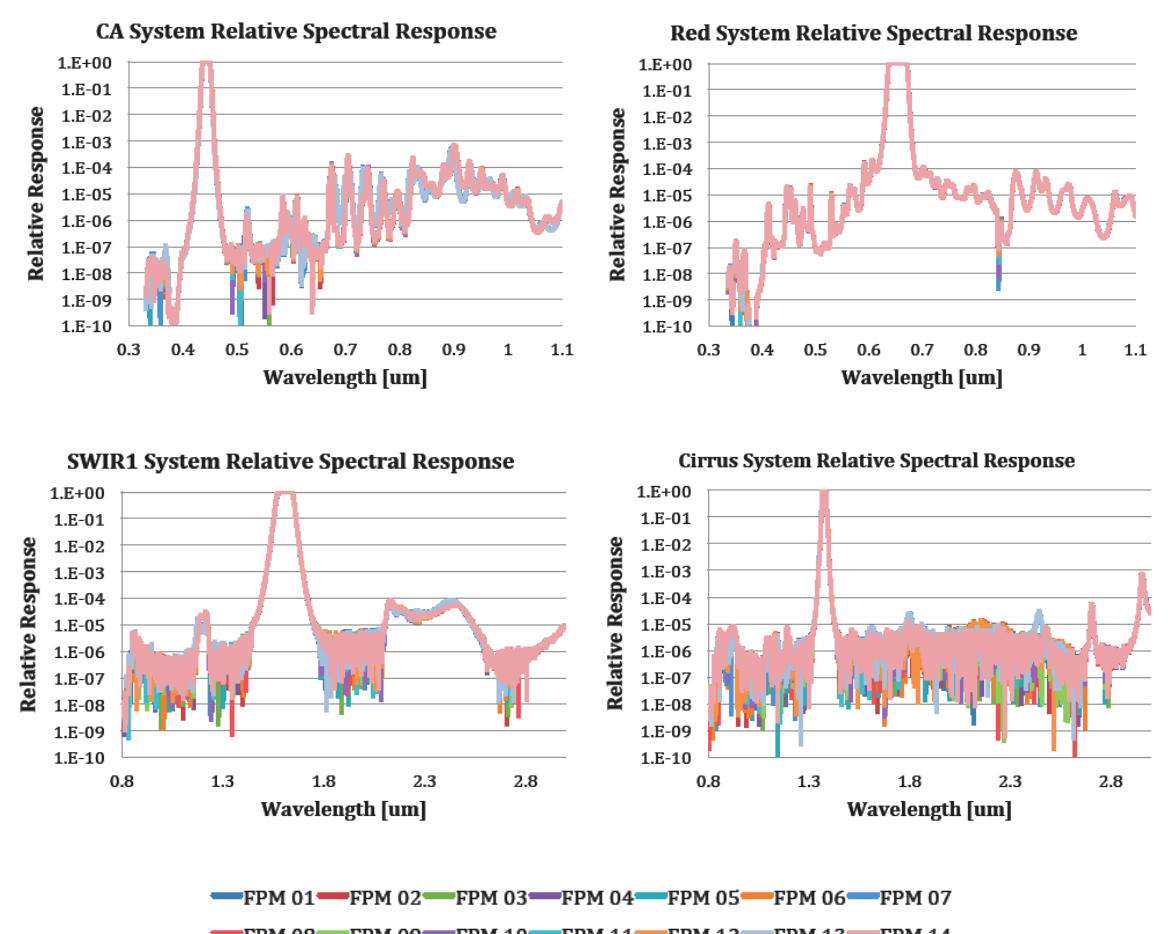
Figure 4. Estimated system-level relative radiance spectral response function of each FPM of the OLI CA ( upper left ), Red ( upper right ), SWIR1 ( lower left ) and Cirrus ( lower right ) bands including the out-of-band response. The out-of-band response is below 1e-3 in all FPMs of all